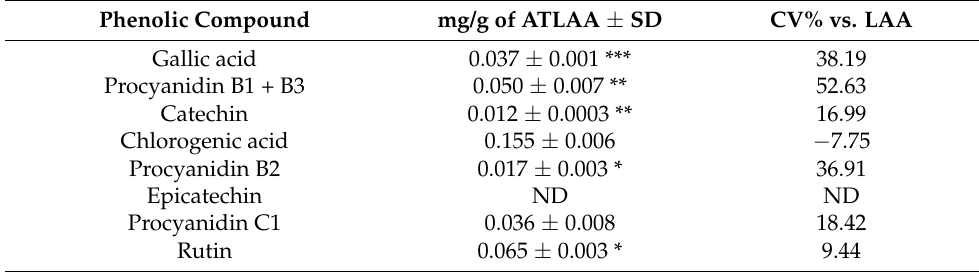
Table 2. Polyphenolic composition of ATLAA polyphenolic bioaccessible fraction vs. polyphenolic bioaccessible fraction of